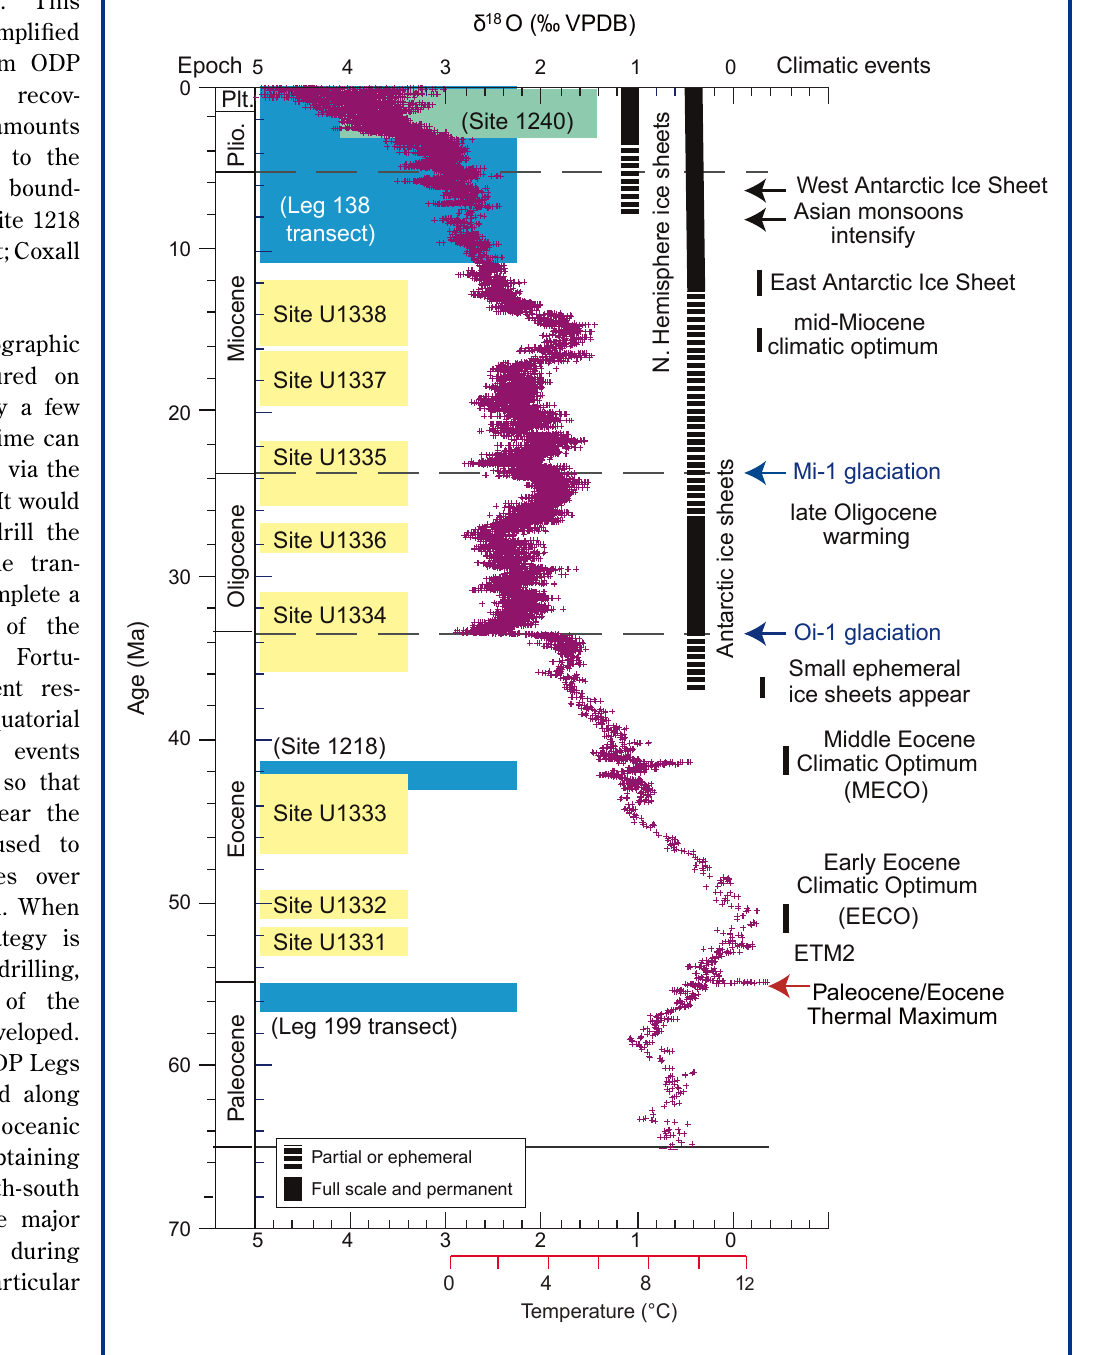
Figure 3. Evolution of oxygen stable isotopes ( δ 18 O) through the Cenozoic and related major phases of climate change (modified from Zachos et al., 2001a, 2008). Yellow boxes = time slices of interest for the PEAT program, green and blue boxes = ODP legs and sites previously drilled in the equatorial Pacific region. These additional sites will be used with the PEAT sites to obtain a nearly continuous Cenozoic record of the equatorial Pacific region. VPDB = Vienna Peedee belemnite. Oi-1 = Oligocene isotopic Event 1, Mi-1 = Miocene isotopic Event 1 (Miller et al., 1991). ETM2 = Eocene thermal maximum